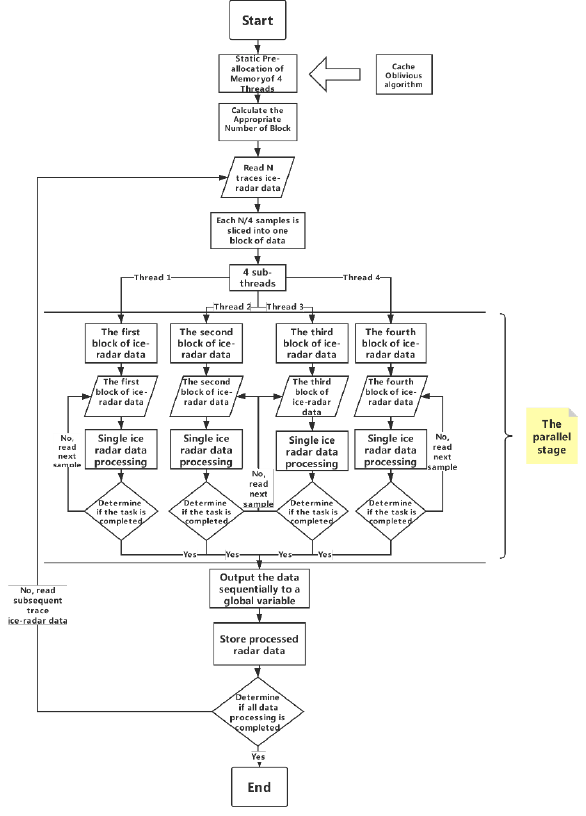
Figure 2. Flowchart of optimized on-site processing program of ice sounding radar